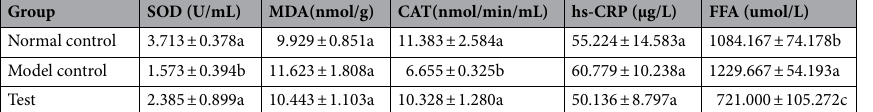
Table 4. Serum oxidative stress of rat fed with LWIF and control diet. Data are mean values ± standard errors of three replicates. Mean values followed by the different letter in the same row are significantly difference ( P <